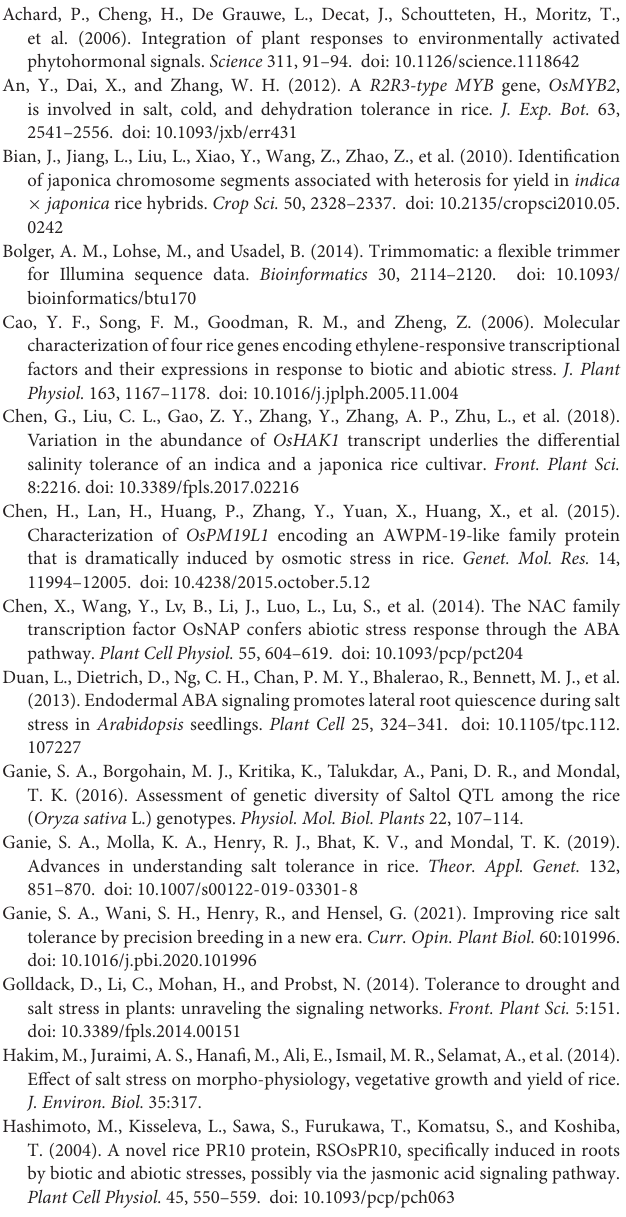
Supplementary Figure 1 | Schematic diagram of salt stress treatment of samples in this study. Supplementary Figure 2 | The high-resolution figure of Figure 4 . Supplementary Table 1 | Sequencing data and sample mapping rates.